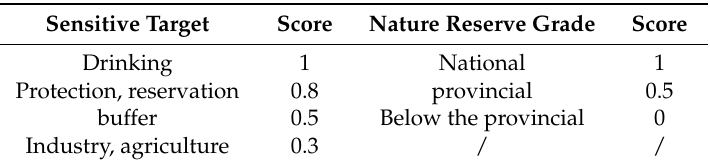
Table 6. Working unit sensitivity assignment